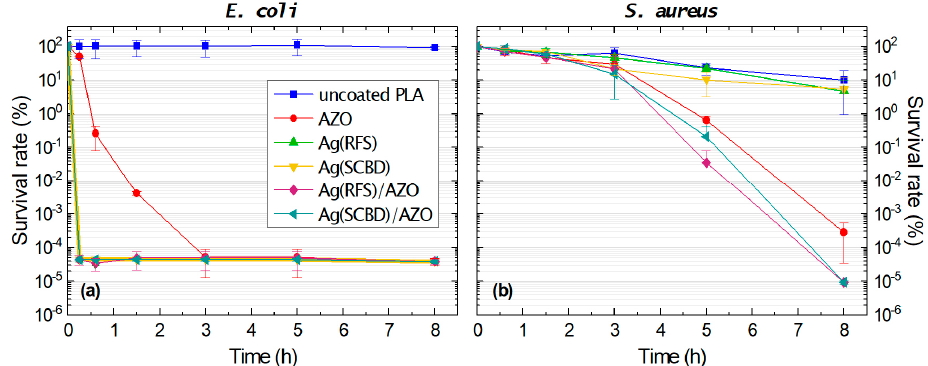
Figure 5. Antibacterial effect of the different samples against ( a ) the Gram-negative bacterium E. coli and ( b ) the Gram-positive bacterium S. aureus , at different time intervals. The survival rate is intended as the percentage reduction of CFU/mL with respect to t = 0. The y axes are in logarithmic scale.